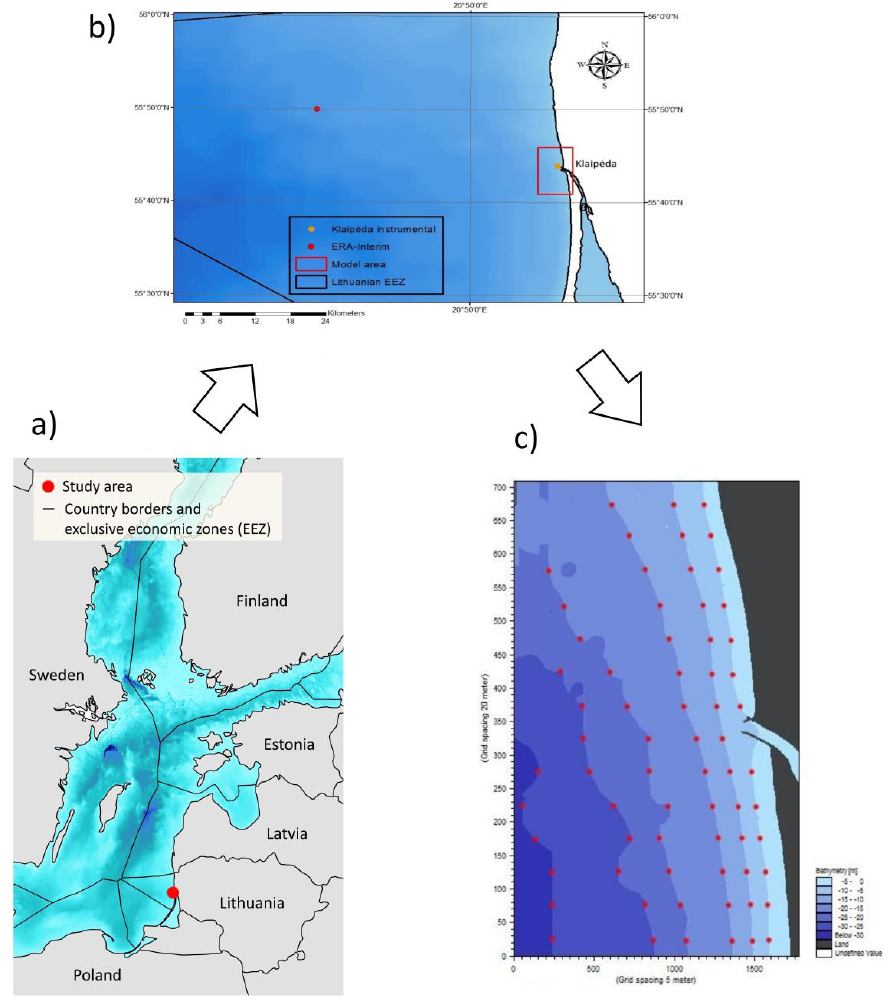
Figure 1. ( a ) Location of the study area in the southeastern part of the Baltic Seal; ( b ) model area together with the available wave data points used for model calibration; ( c ) bathymetry of the model area and calculation points.